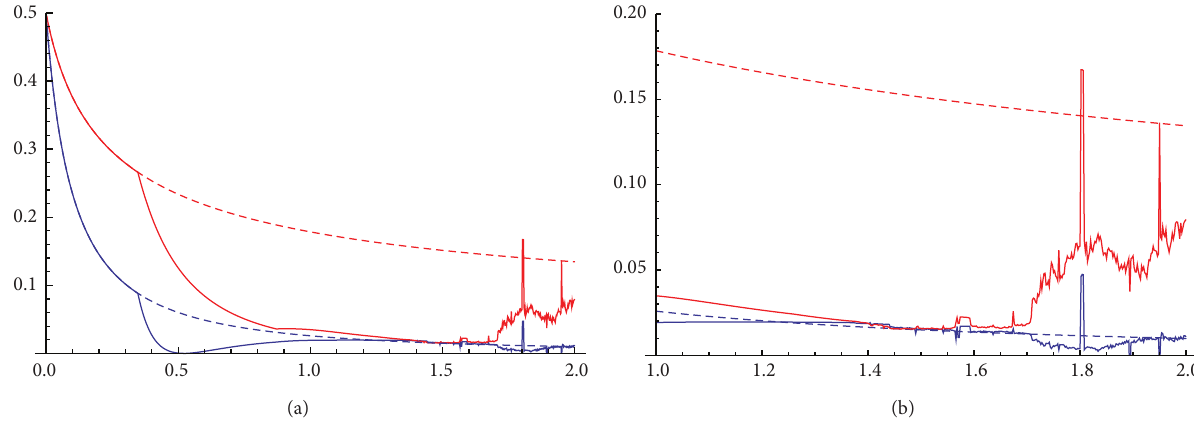
Figure 22: In this case 𝛼 = 1.3 , but the initial conditions are 𝑥 0 = 1/𝛽 and 𝑦 0 = 0.001 . The code is the same as in Figure 21. With these initial conditions there are points in which the profit of firm 1 (close to 𝛽 = 1.56 ) is greater than the profit reached in the Cournot